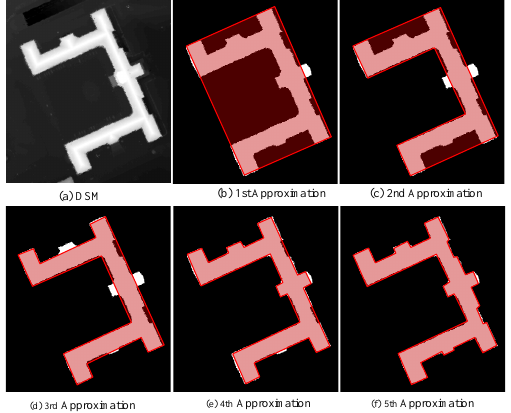
Figure 1: 2D generalization; different approximation levels